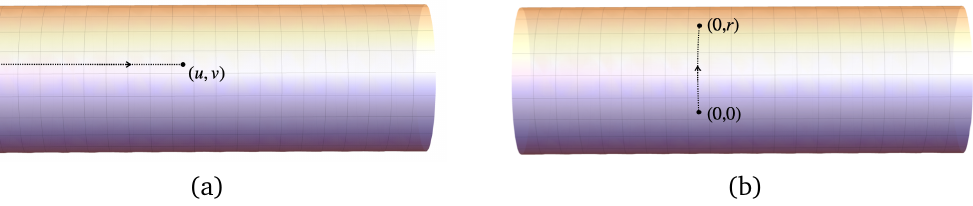
Figure 1: (a) The operator v α ( u , v ) in the six-vertex model. (b) The two-point func- ( 0,0 ) v ( 0, r ) 〉 . Each oriented dotted line represents the product of operators tion 〈 v † α α / 2 ) on the edges it exp ( i ασ z j